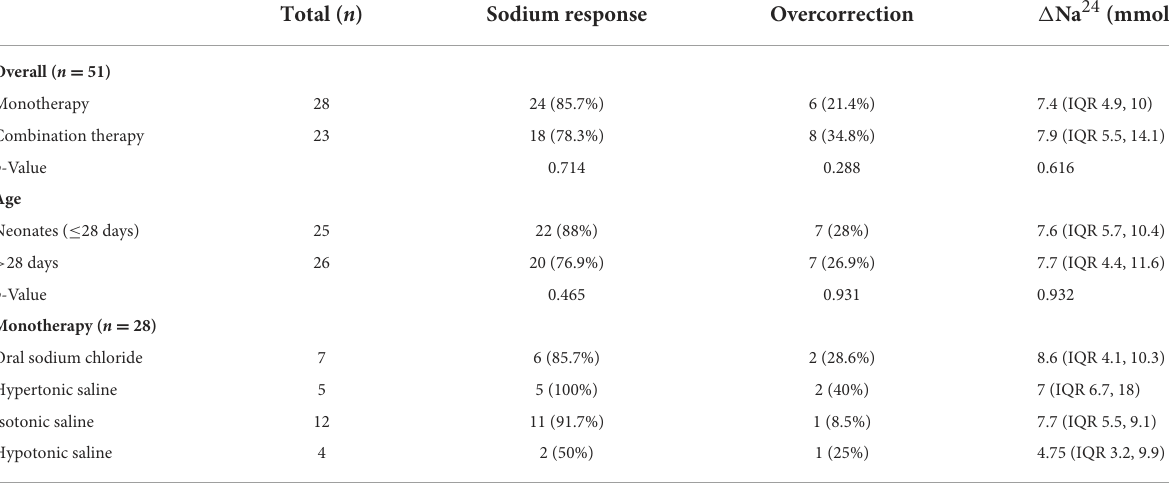
TABLE 3 Sodium response, overcorrection, and 24-h change in sodium with treatment.